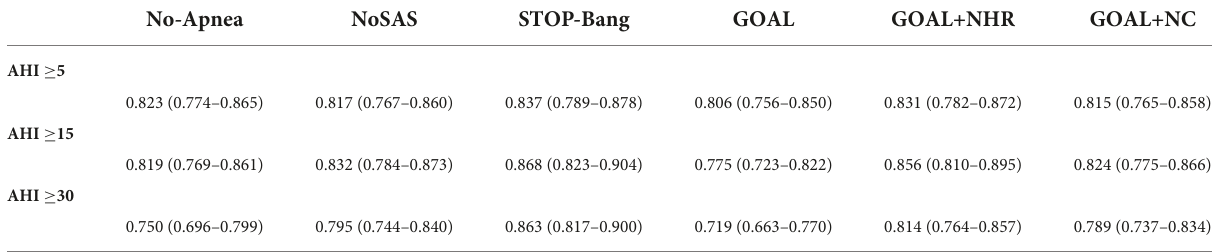
TABLE 3 Identification ability of screening